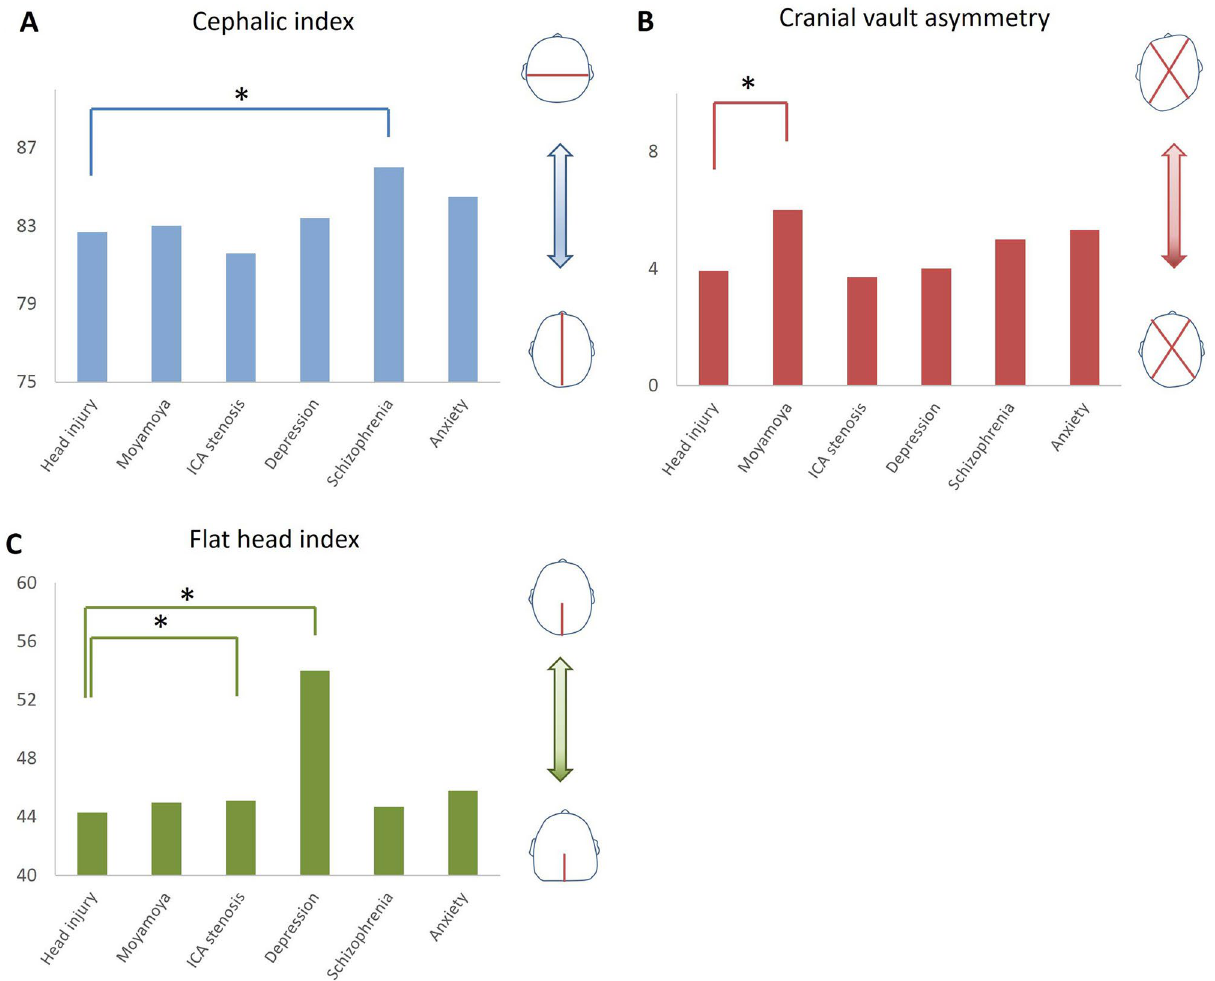
subjects (head injury) are indicated with an asterisk